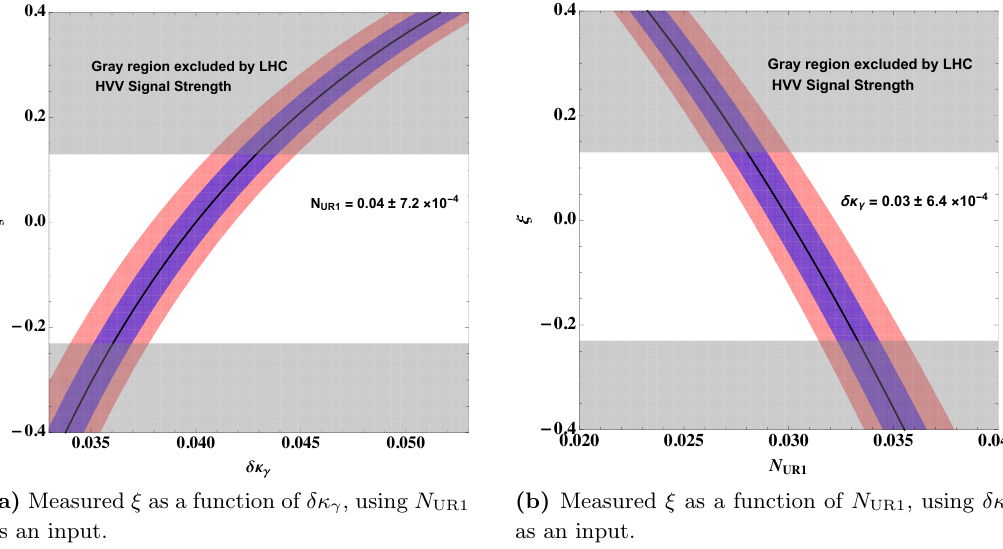
Figure 5. Using UR1 to measure (cid:24) , where the blue and red bands correspond to the 1 (cid:27) and 2 (cid:27) region on the